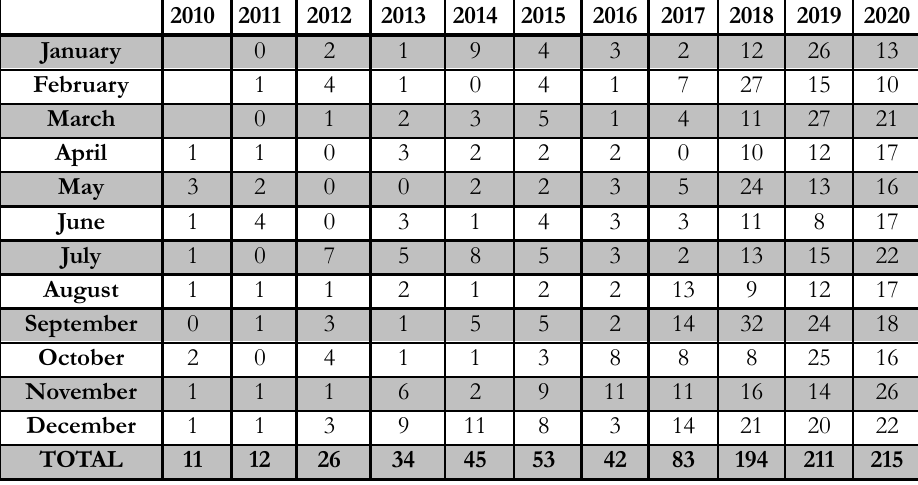
Table 1. Article submissions evolution from 2010 to 2020